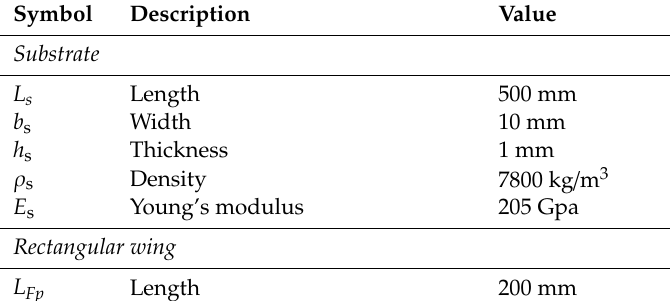
Figure 3. Variations of the potential energy function with tip deflection for different equivalent aero-dynamic stiffness (EAS) values. Table 1. Model parameters used for simulation and experiment.